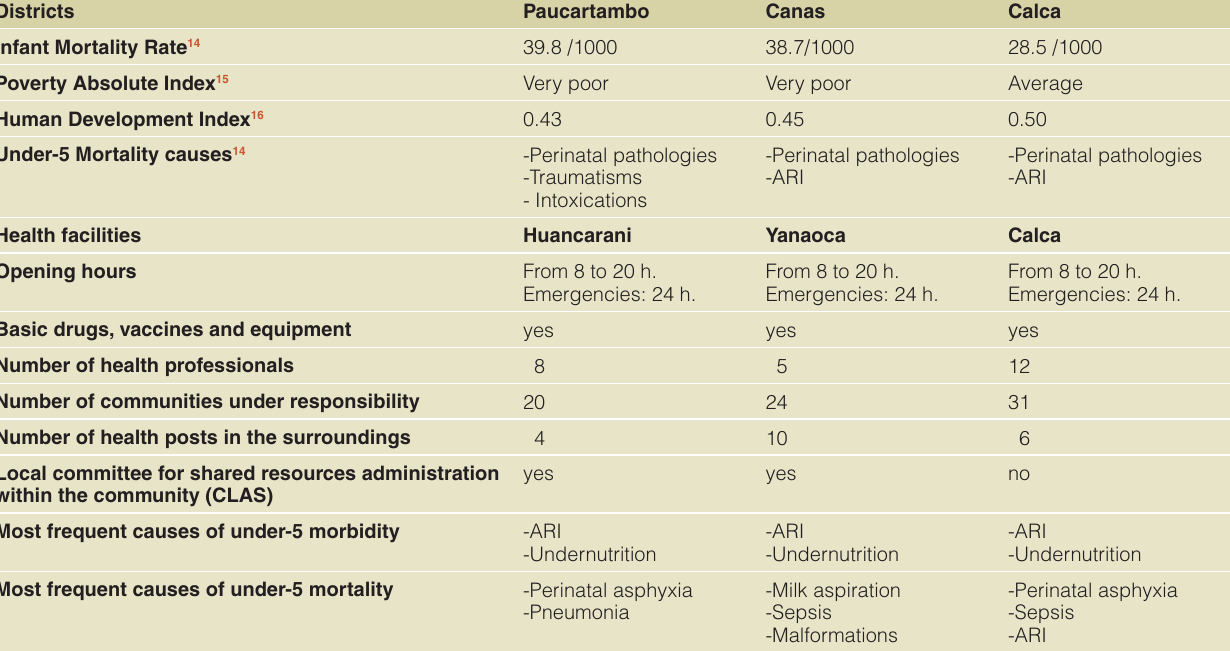
Table 1. Health characteristics of selected districts and health facilities in three districts in the Cusco region,